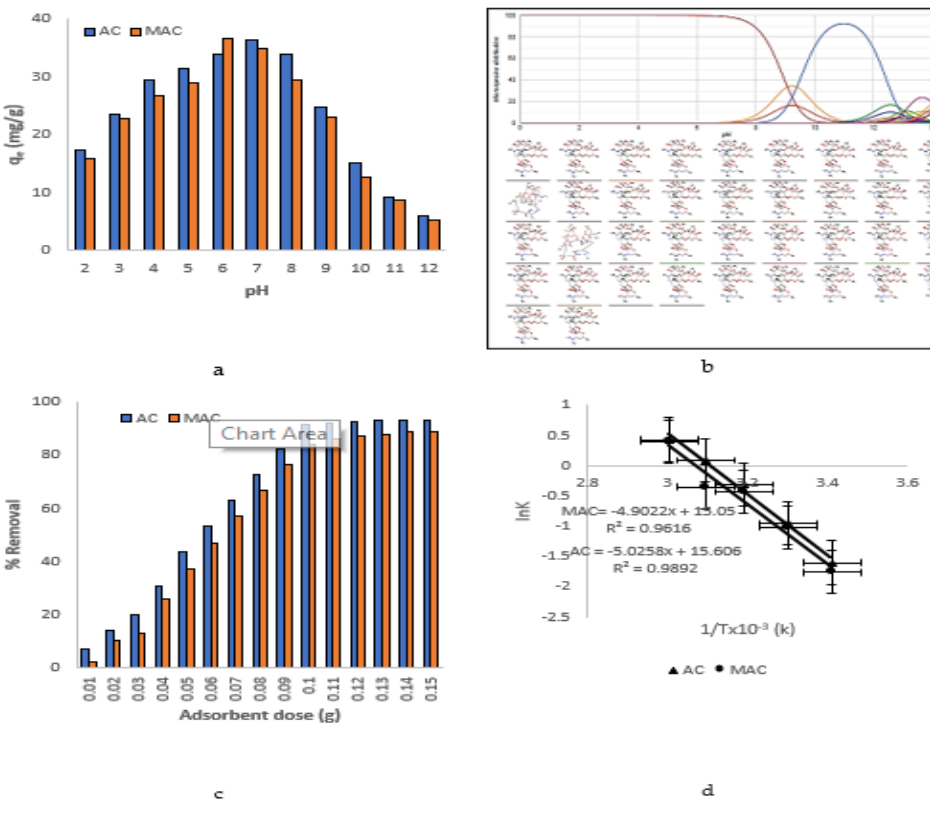
Figure 10. ( a ) Effect of pH ( b ) microspecies distribution ( c ) effect of adsorbents dose ( d ) Van’t Hoff plots.